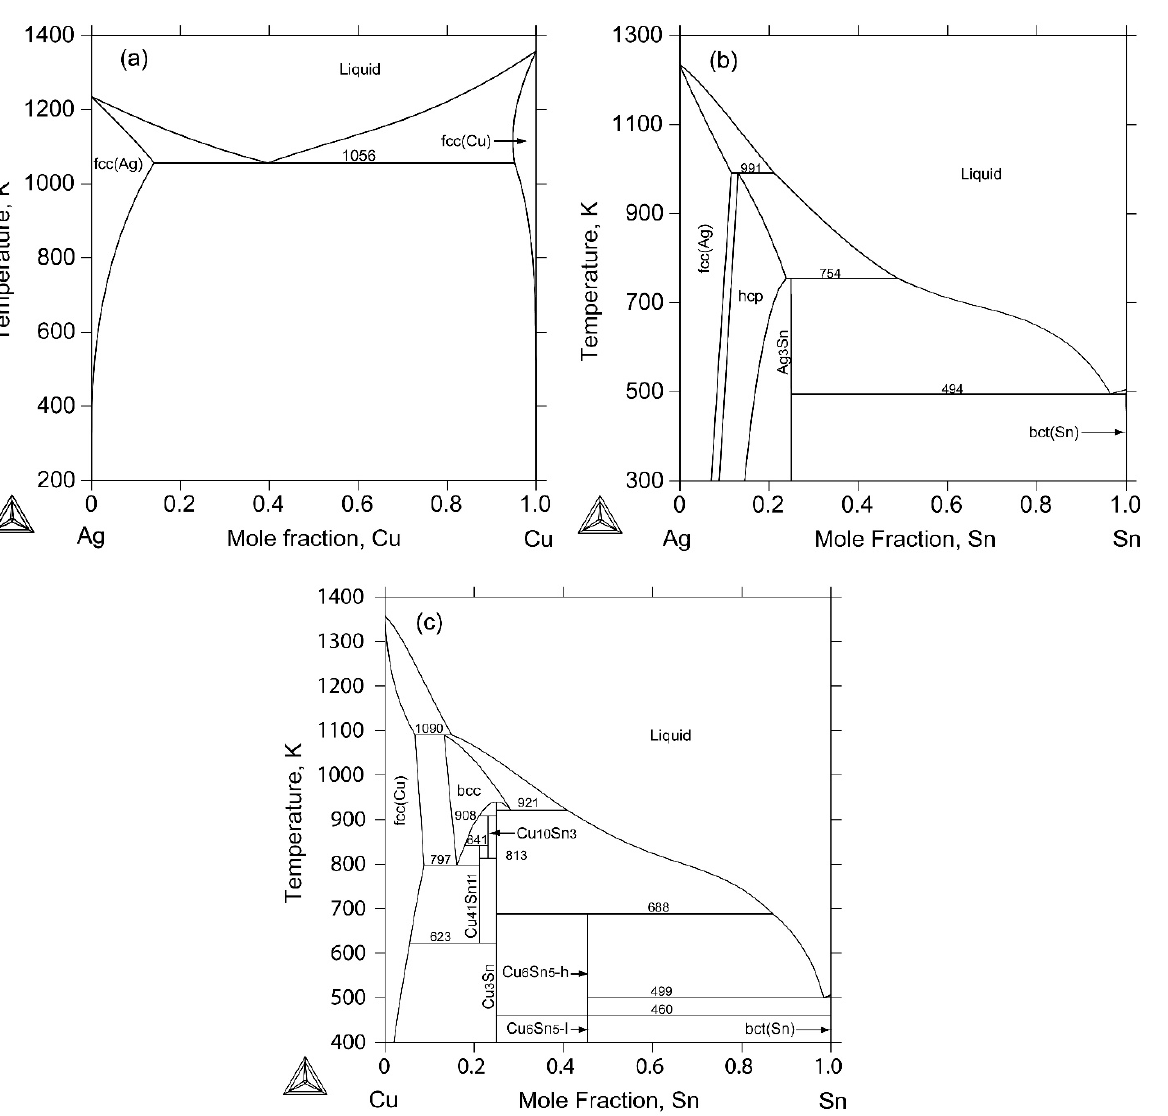
Figure 1. Calculated ( a ) Ag-Cu, ( b ) Ag-Sn and ( c ) Cu-Sn sub-binary phase diagrams by He et al. [32], Du et al. [33] and Liu et al. [34].